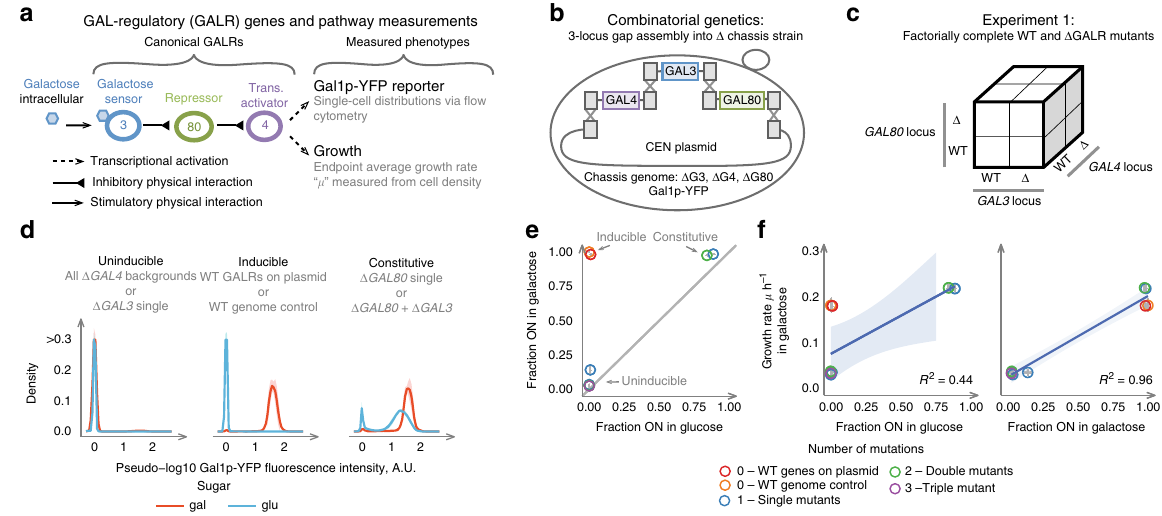
Fig. 1 Combinatorial genetic analysis of the GAL pathway. a Overview of GAL pathway regulation. b In vivo homologous recombination to combine alleles of three GALR genes into a chassis strain with all three genes deleted. c Cubic representation of combinatorially complete genetics experiments combining alleles in multiple loci. d Three phenotypic classes of GALR deletion mutants. Lines and shading are the mean and ± 1 SD of genotypes falling into the given expression class ( N = 4 for N = 2 independent transformations for each unique genotype). Blue lines are samples growing in glucose and red lines are samples after 12 h of growth in galactose. e Expression distributions summarized by the fraction of cells ON in galactose and glucose. Points are mean values for each unique genotype, and are colored to re fl ect the number of mutations. f Fraction ON in glucose and galactose predicts growth rate. Blue line and shaded region are the expectation and 95% con fi dence interval of a linear